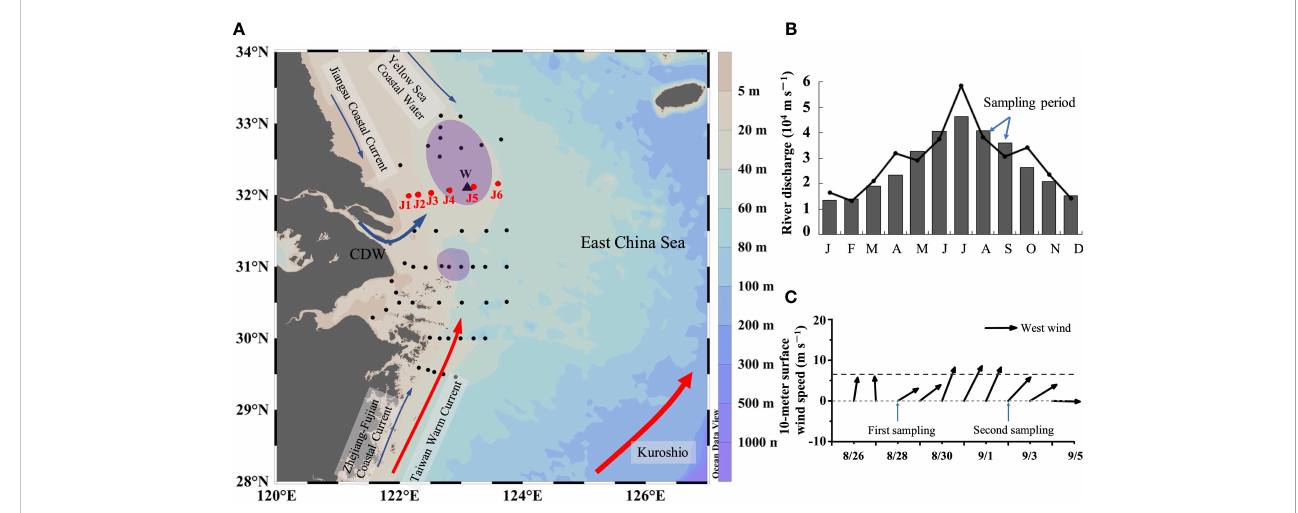
FIGURE 1 (A) Sampling stations and the bottom hypoxic zones (purple polygons) during the cruises. The red dots (JI~J6) are repeated sampling stations. The black triangle (W) is the wind observation site from WindSat. (B) Changjiang River discharge at the Datong hydrological station (data from: http://www.cjw.gov. cn/zwzc/bmgb/). The gray bars show the average monthly river discharge for 2000 – 2017. The broken line represents the average monthly net fl ow in 2017. (C) 10-m surface wind speed at W from August 26 to September 5 of 2017. The dashed gray line represents the average wind speed (6.7 m/s – 1 )